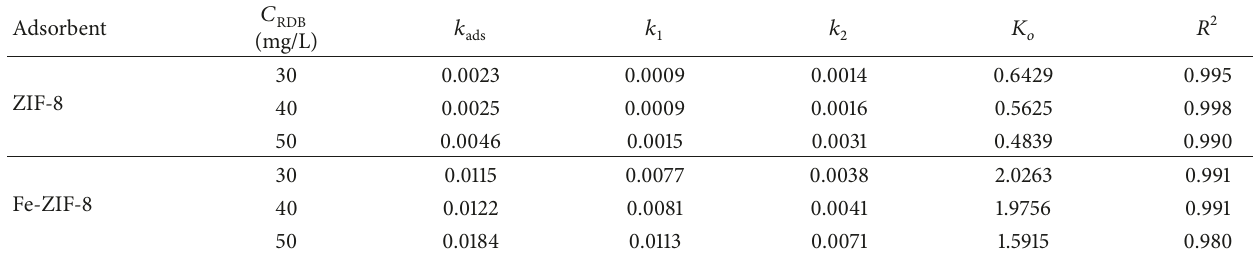
Table 5: Rate constants for the adsorption and the rate constants for the forward and reverse process and equilibrium constants at different concentrations for ZIF-8 and Fe-ZIF-8.